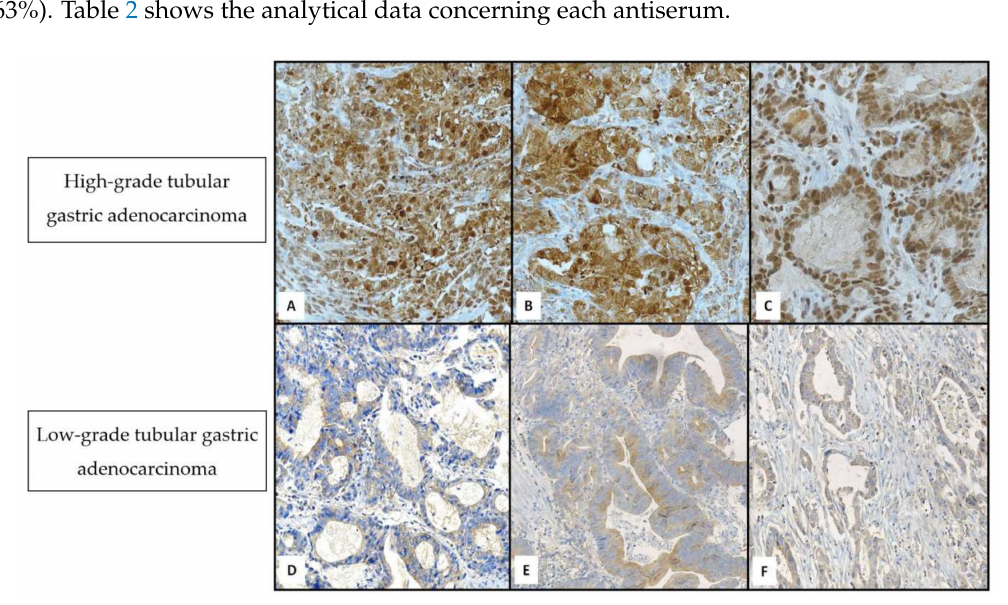
An evident strong and diffuse cytoplasmic and/or nuclear immunoreactivity was encountered in high-grade tubular gastric adenocarcinomas by LC3A/B ( A , 160 × ), Beclin-1 ( B , 160 × ) and AMBRA-1 ( C , 200 × ); by contrast, a slight not uniform staining was found in low-grade cancer with LC3A/B ( D , 120 × ), Beclin-1 ( E , 120 × ) and AMBRA-1 ( F , 140 × ). Nuclear Mayer’s haemalum